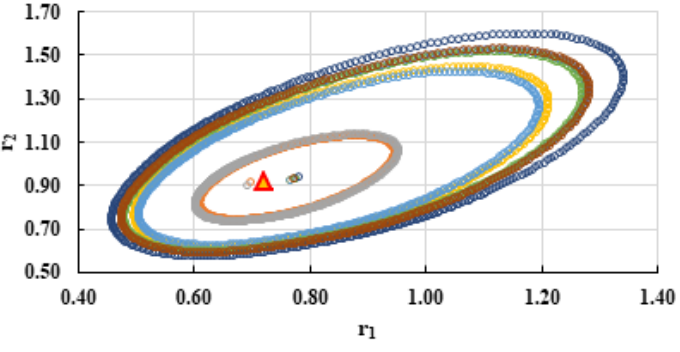
Figure 17. The JCR of analyzed methods for reactivity ratios calculation for HC2 imposed condition.